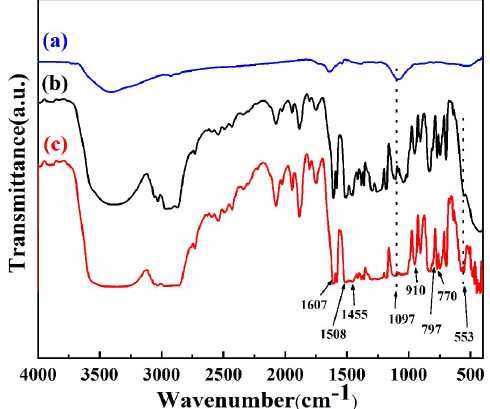
Figure 8. FTIR spectra of ( a ) GO-Ti composite, ( b ) EP, and ( c ) GO-Ti / EP coating.